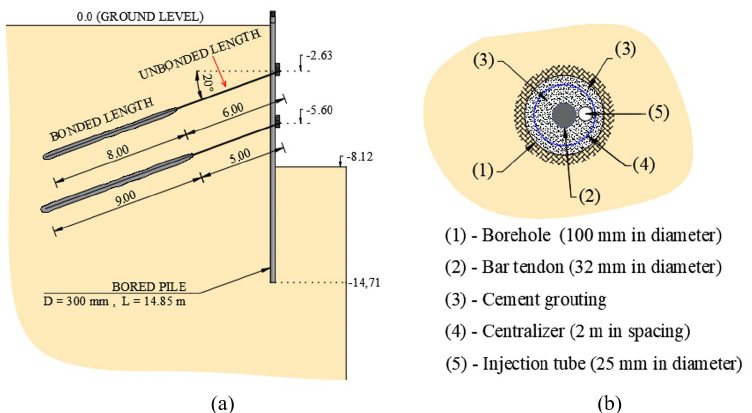
Figure 2 - (a) Schematic showing the cross-section view of the retaining wall system (units: m); (b) detail of the anchor assembly in the bonded length.